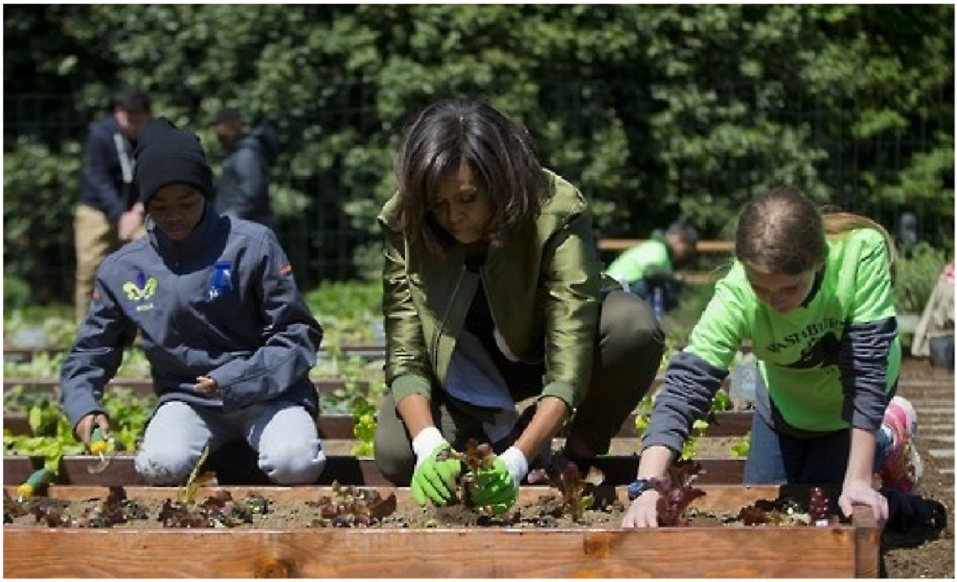
Figure 6. Michelle Obama in the White House “kitchen garden” [47].